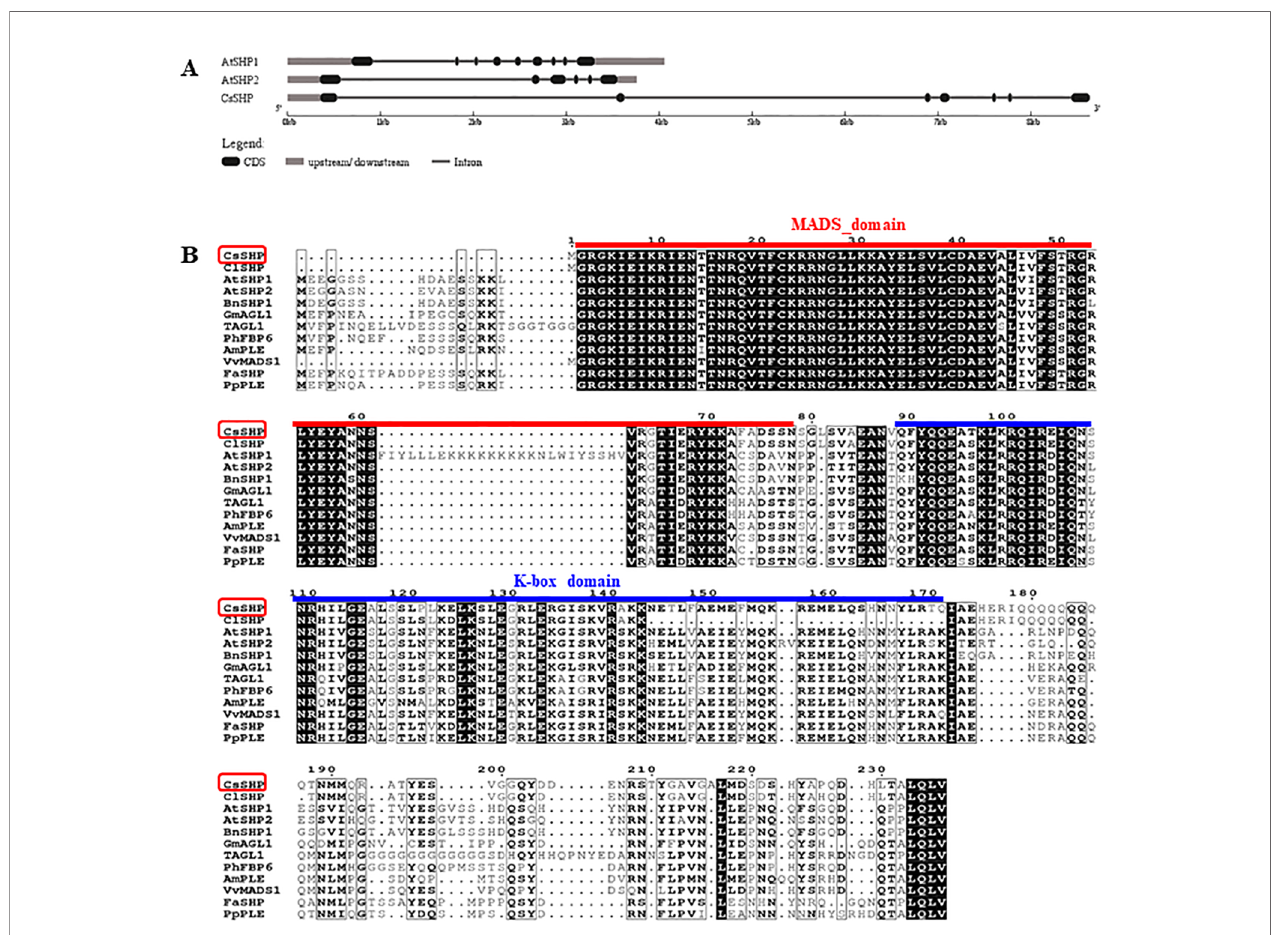
FIGURE 1 | Gene structure and sequence alignment. (A) Gene structure analysis of SHP1 , SHP2 , and CsSHP . (B) Multiple sequence alignment of CsSHP and orthologs from related plant species. The red and blue lines indicate the conserved MADS domain and K-box domain,